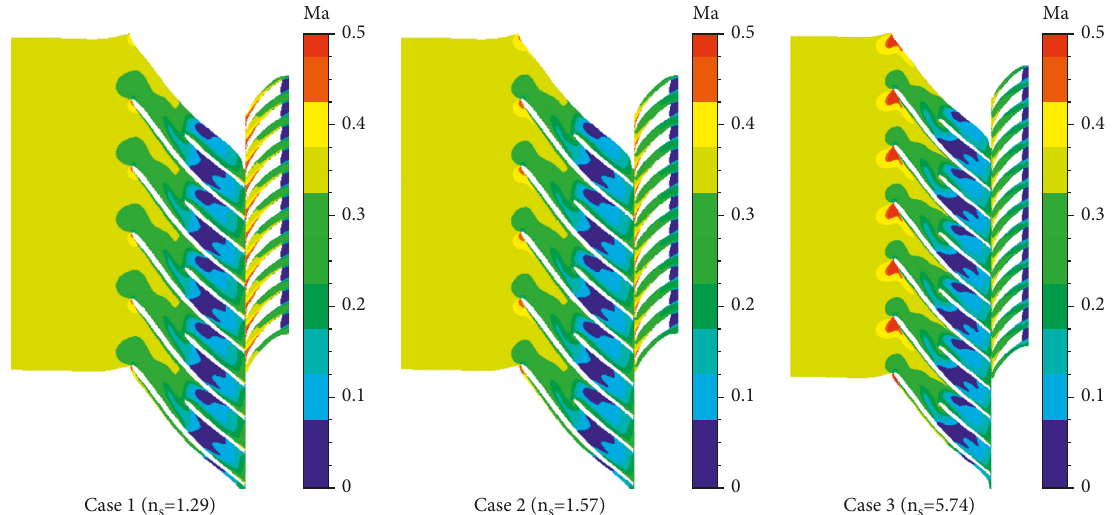
Figure 18: Mach number distribution of test cases (at 85% span).